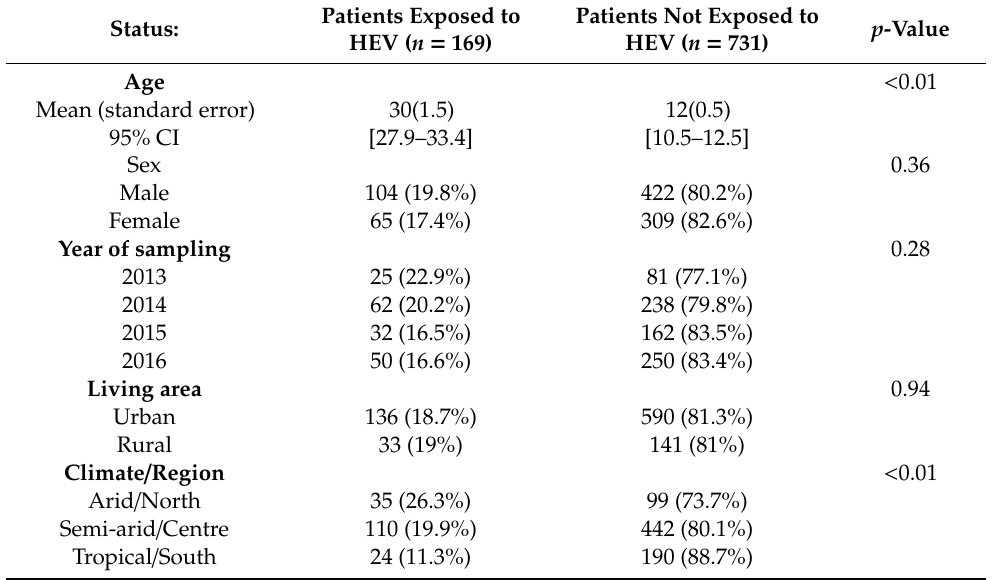
Table 2. Demographic characteristics of patients according to HEV